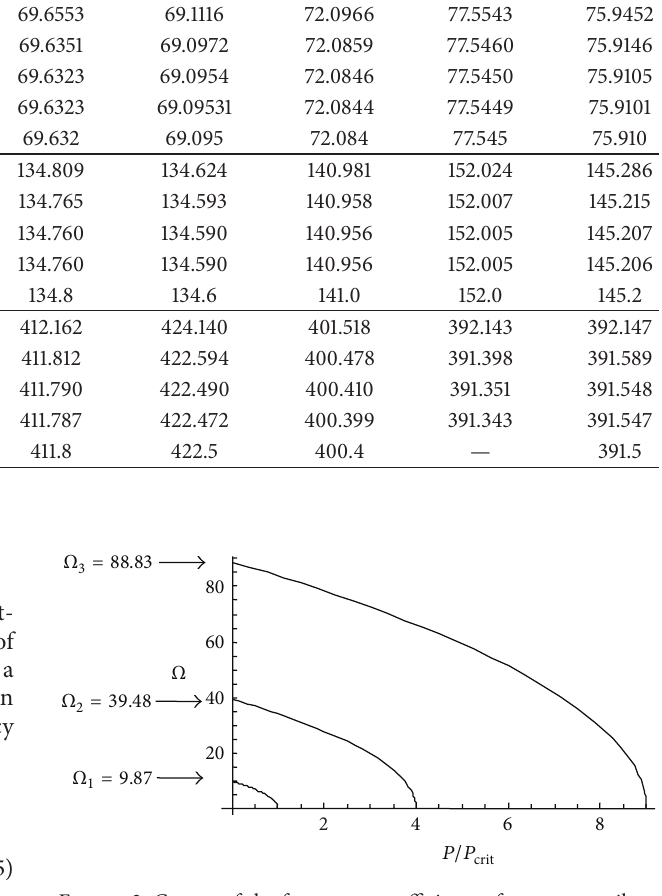
Figure 2: Curves of the frequency coefficients of transverse vibra- tion for a pinned-pinned beam under axial compressive load 𝑃